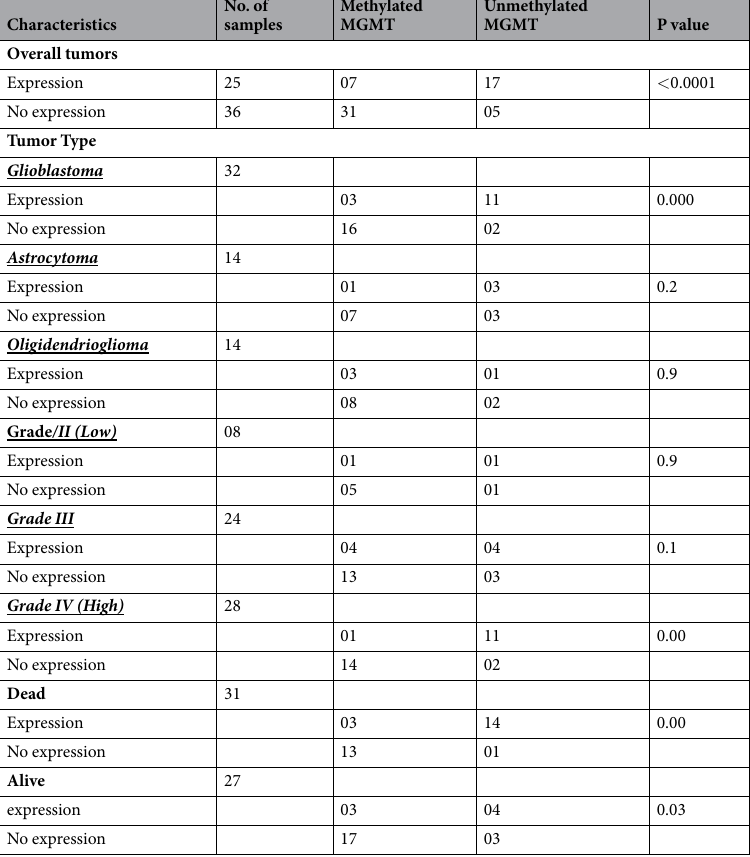
Table 1. Association of MGMT methylation and loss of MGMT protein expression in different parameters of Glioma